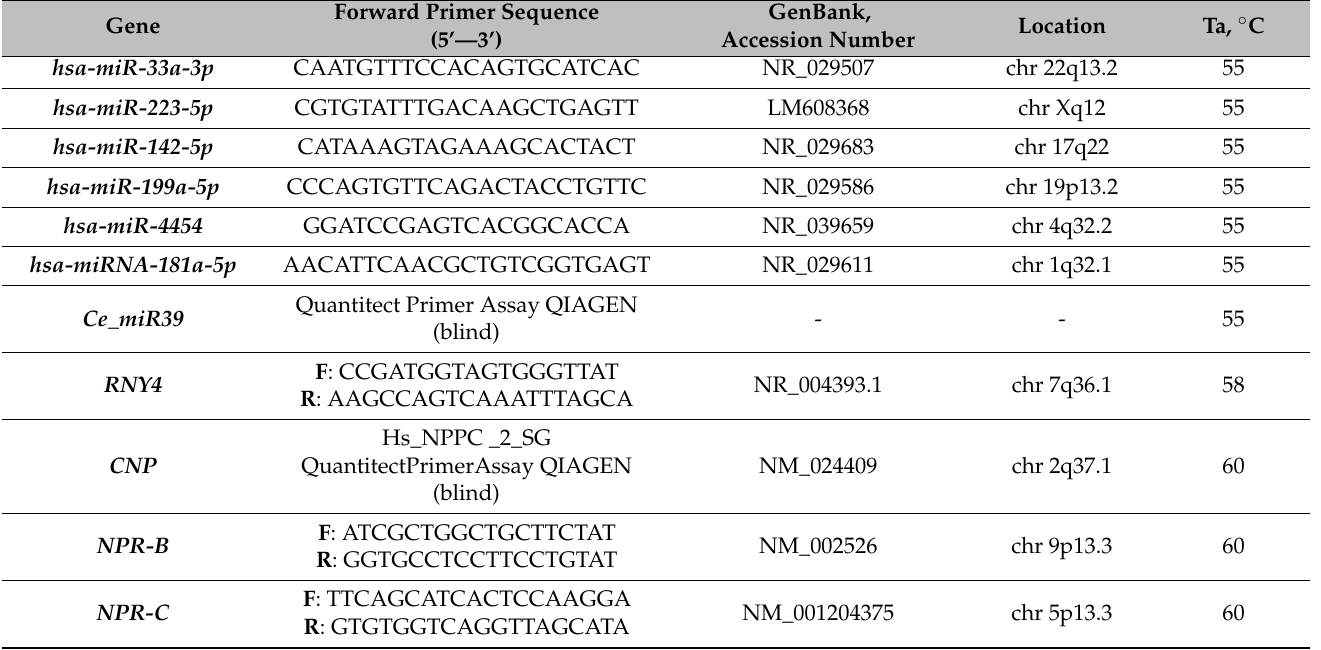
Table legend . hsa-miR-33a-3p: homo sapiens microRNA-33a with 3p strand present in the reverse position; hsa-miR-223-5p : homo sapiens microRNA-223 with 5p strand present in the forward position; hsa-miR-142-5p : homo sapiens microRNA-142 with 5p strand present in the forward position; hsa-miR-199a-5p : homo sapiens microRNA-199a with 5p strand pre-sent in the forward position; hsa-miR-4454 : homo sapiens microRNA-4454 ; hsa-miR-181a-5p : homo sapiens mi-croRNA-181a with 5p strand present in the forward position; Ce_miR39 : C. elegans miR-39 miRNA mimic; RNY4 : Homo sapiens RNA, Ro60-associated Y4 (RNY4), Y RNA; CNP : or NPPC , C-type natriuretic peptide; NPR-B: or NPR2 or GC-B, natriuretic peptide receptor B; NPR-C: or NPR3 , natriuretic peptide receptor C or clearance